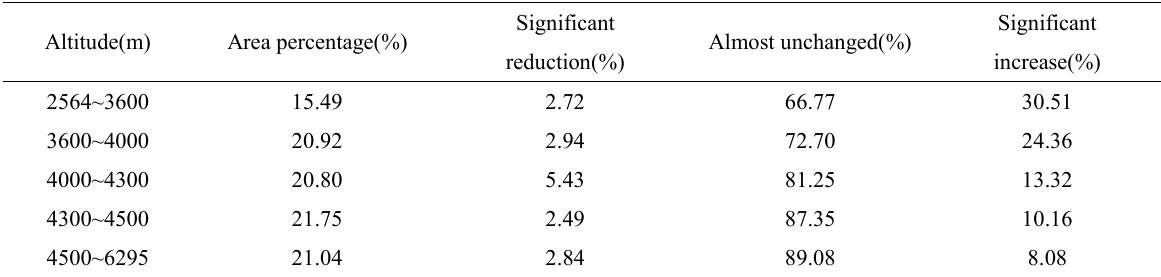
Table 2. Changes of FVC at different elevation gradients in the source region of the Yellow River